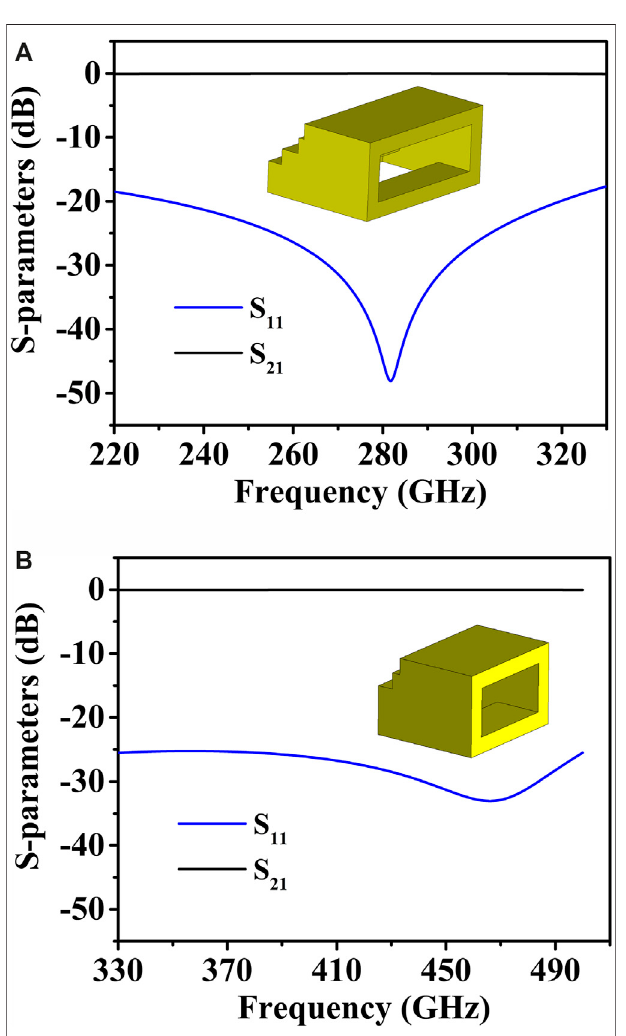
FIGURE 5 | Simulated results of two bend transitions. (A) Bend used in WR-3.4 band. (B) Bend used in WR-2.2 band